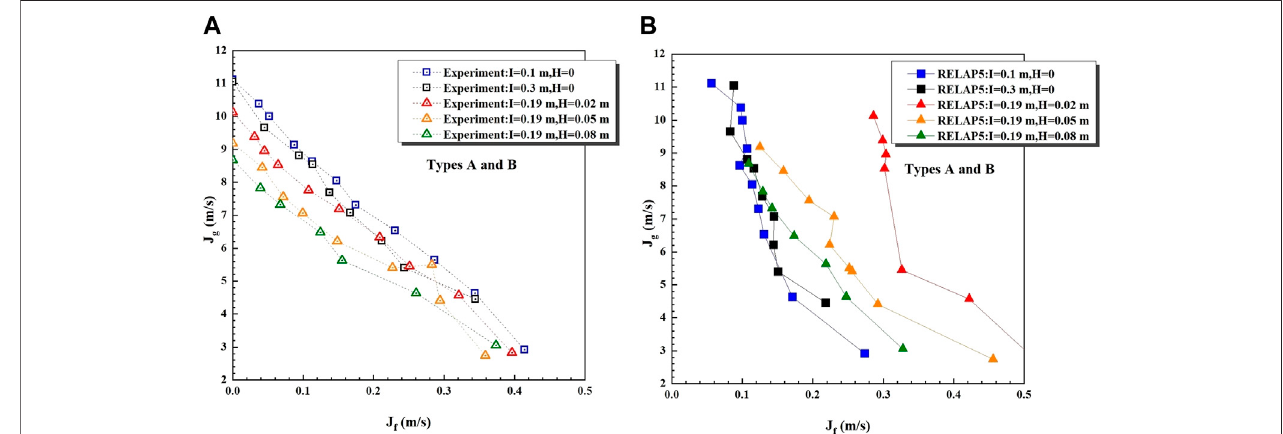
FIGURE 9 | Summary of experimental and RELAP5 data (0.19 m long inclined pipe).